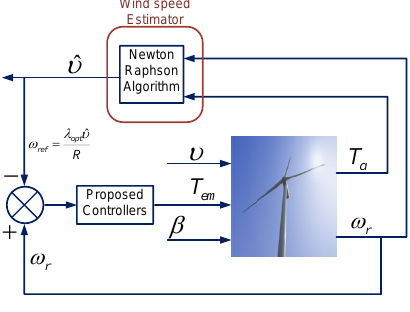
Figure 3. Wind speed